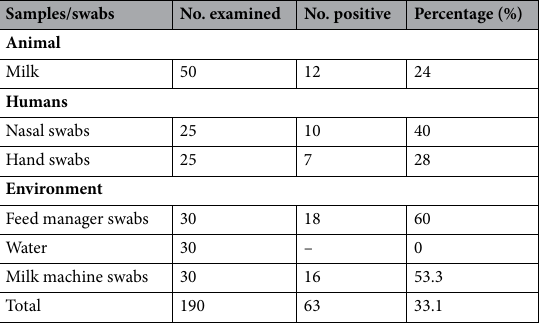
Table 2. Prevalence of S. aureus isolated from animal, human and environmental samples collected throughout the study. X 2 = 48.83. P < 0.001.